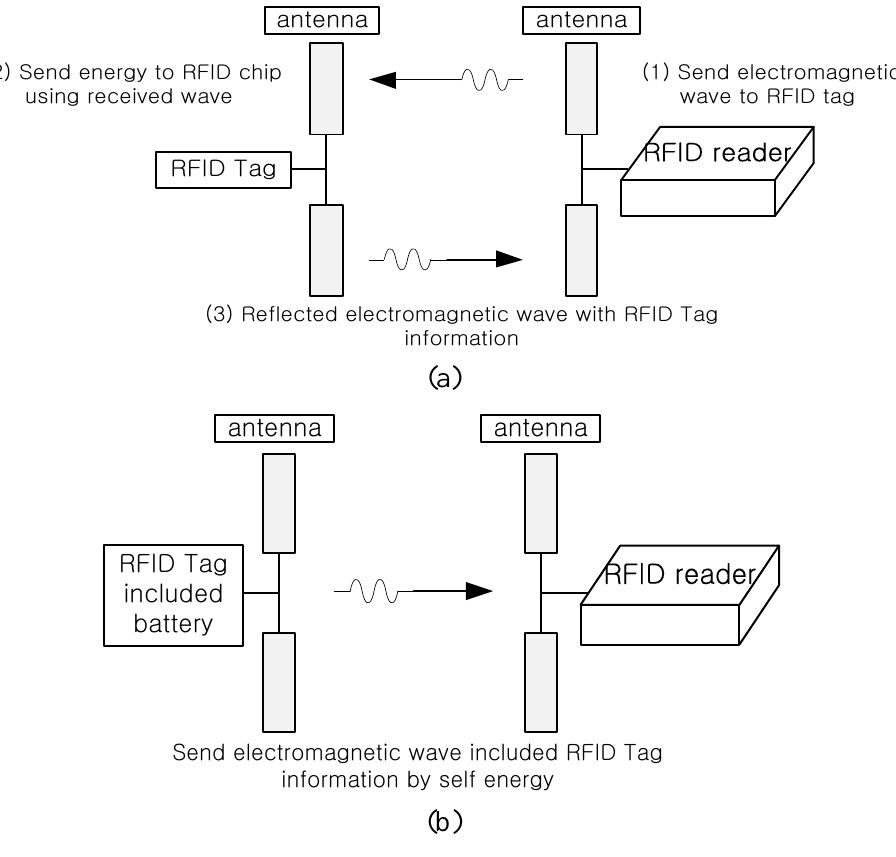
Figure 1. Operation of two types of RFIDtag. ( a ) Passive type RFID tag; ( b ) Active type RFID tag.